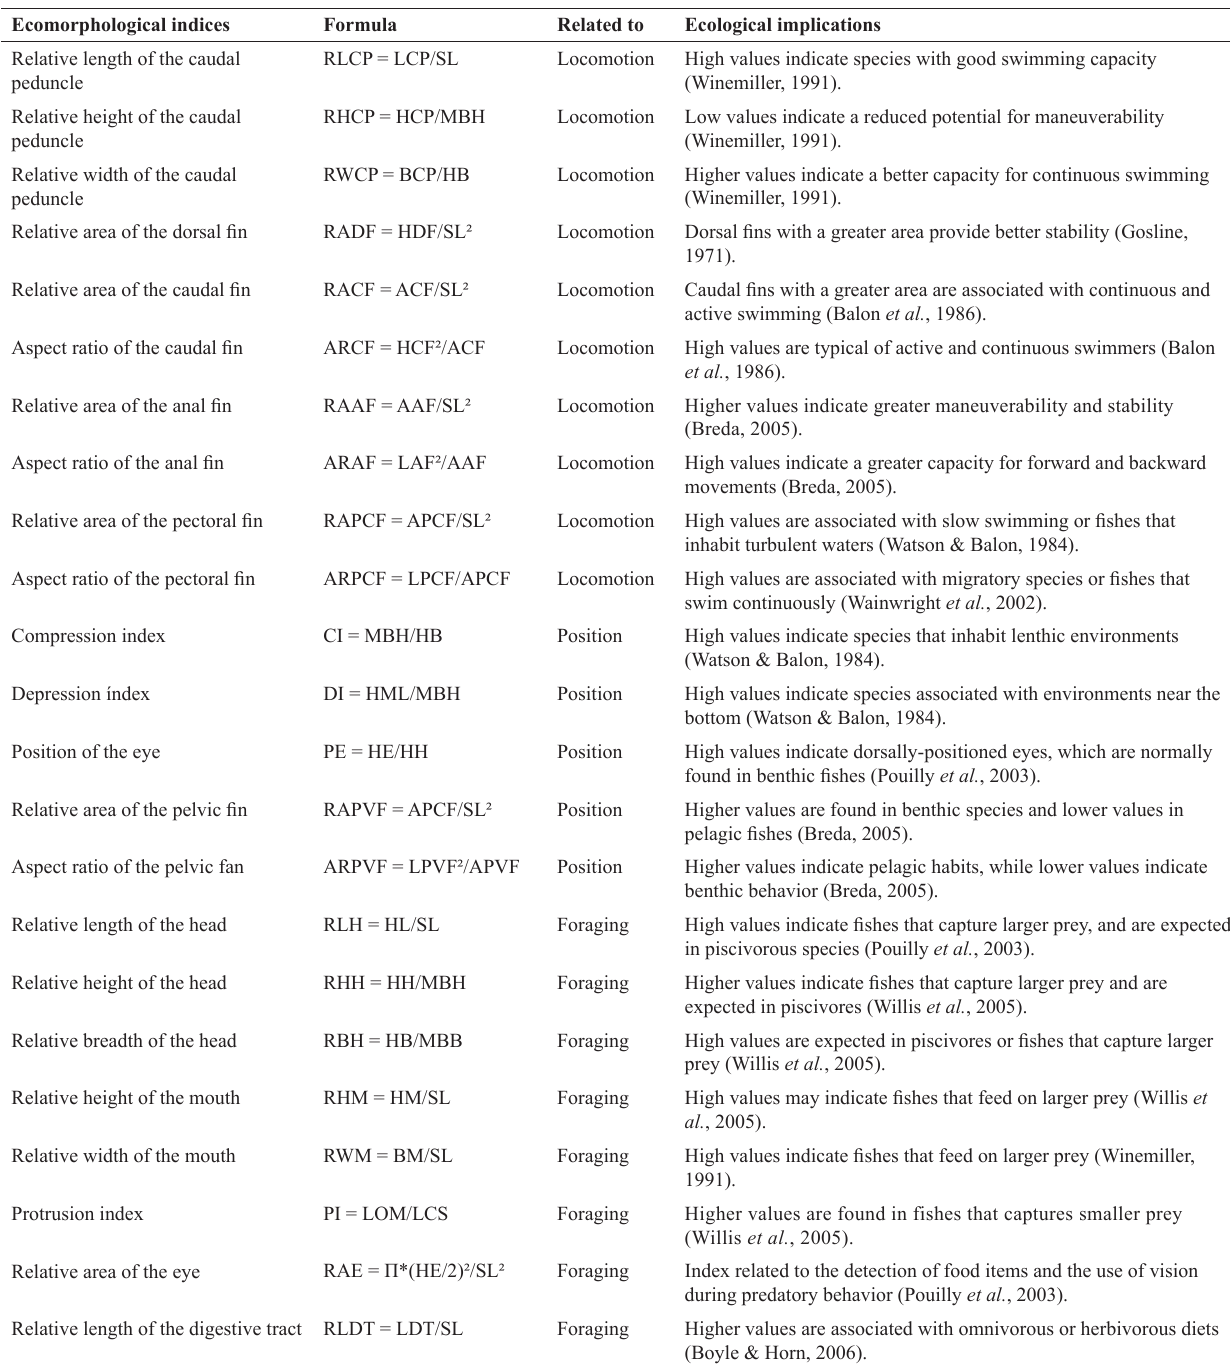
Table 1. Ecomorphological indices adopted in the present study and their respective formulae and ecological interpretation. Codes: area of the anal fin (AAF), area of the caudal fin (ACF), area of the pectoral fin (APCF), area of the pelvic fin (APVF), breadth of the caudal peduncle (BCP), breadth of the mouth (BM), head breadth (HB), head height (HH), head length (HL), height of the caudal fin (HCF), height of the caudal peduncle (HCP), height of the dorsal fin (HDF), height of the eye (HE), height of the midline (HML), height of the mouth (HM), length of the anal fin (LAF), length of the caudal peduncle (LCP), length of closed snout (LCS), length of the digestive tract (LDT), length of open mouth (LOM), length of the pectoral Ecomorphological indices